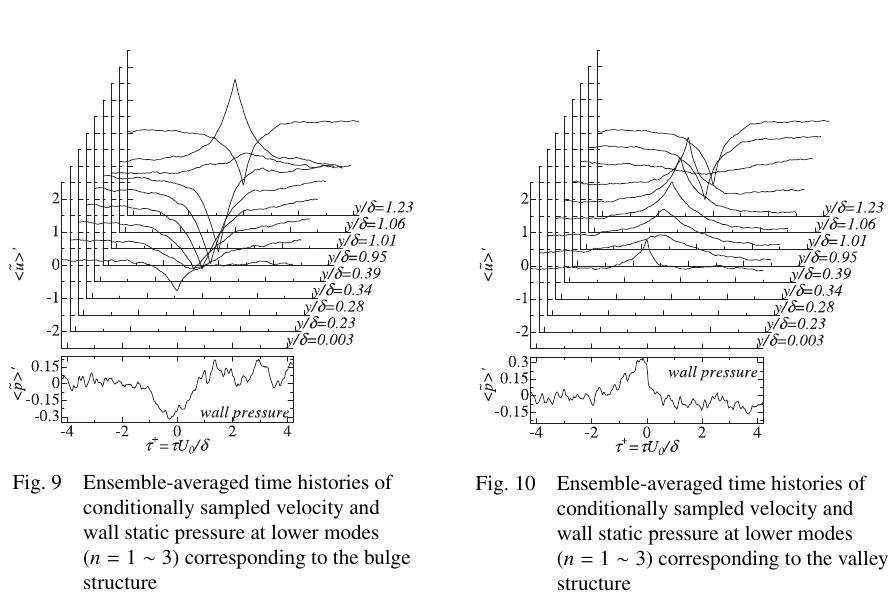
Fig. 10 Ensemble-averaged time histories of conditionally sampled velocity and wall static pressure at lower modes ( n = 1 ∼ 3) corresponding to the valley structure